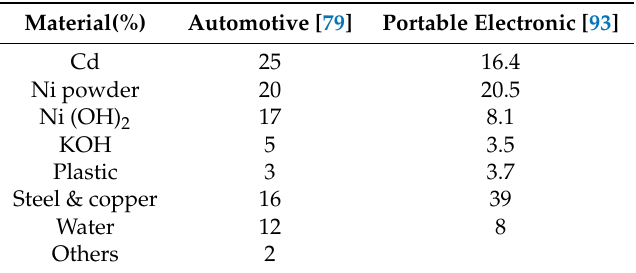
Table 5. Typical materials composition (by percentage weight) of the Nickel-Cadmium Battery types used for automotive and portable electronic